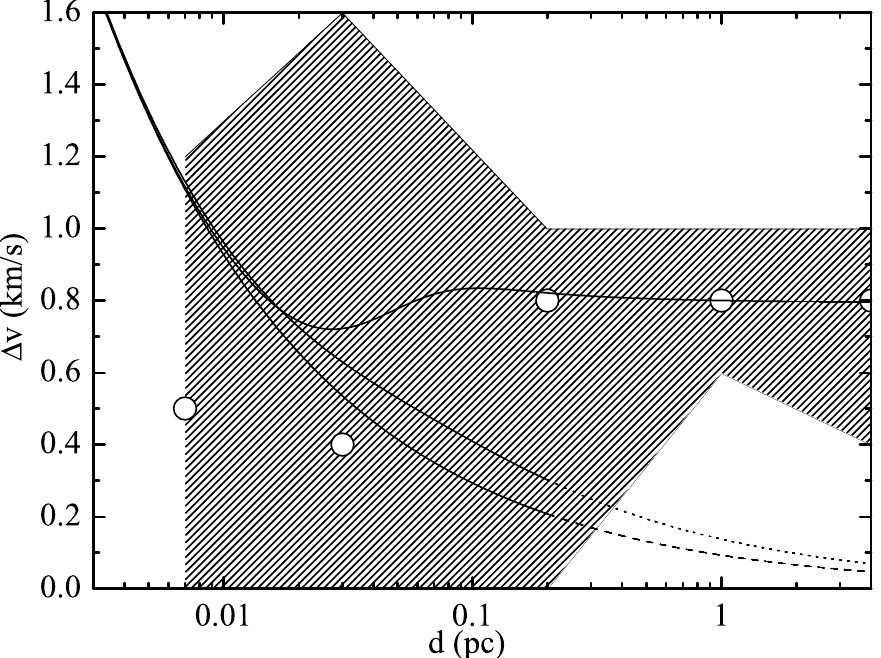
Figure 2. Observations of Hernández et al. [72] for the relative velocity of two binary stars of mass equal to that of the Sun at separations ranging from 0.07 pc to 4 pc. The estimated relative velocities are shown as open circles, with uncertainty corresponding to the shaded area. Predictions of Newtonian theory are given by the lower dashed line. The dotted line is the MOND prediction and the solid line is the prediction of the MNG as discussed in this paper for κ = 3.109 and β = 8737 AU. Notice the similarity of the predictions of MNG with MOND without the external field effect as discussed by Banik and Zhao [80]. This could falsify the MNG model in light of the data release 2, as discussed by Pittordis and Sutherland